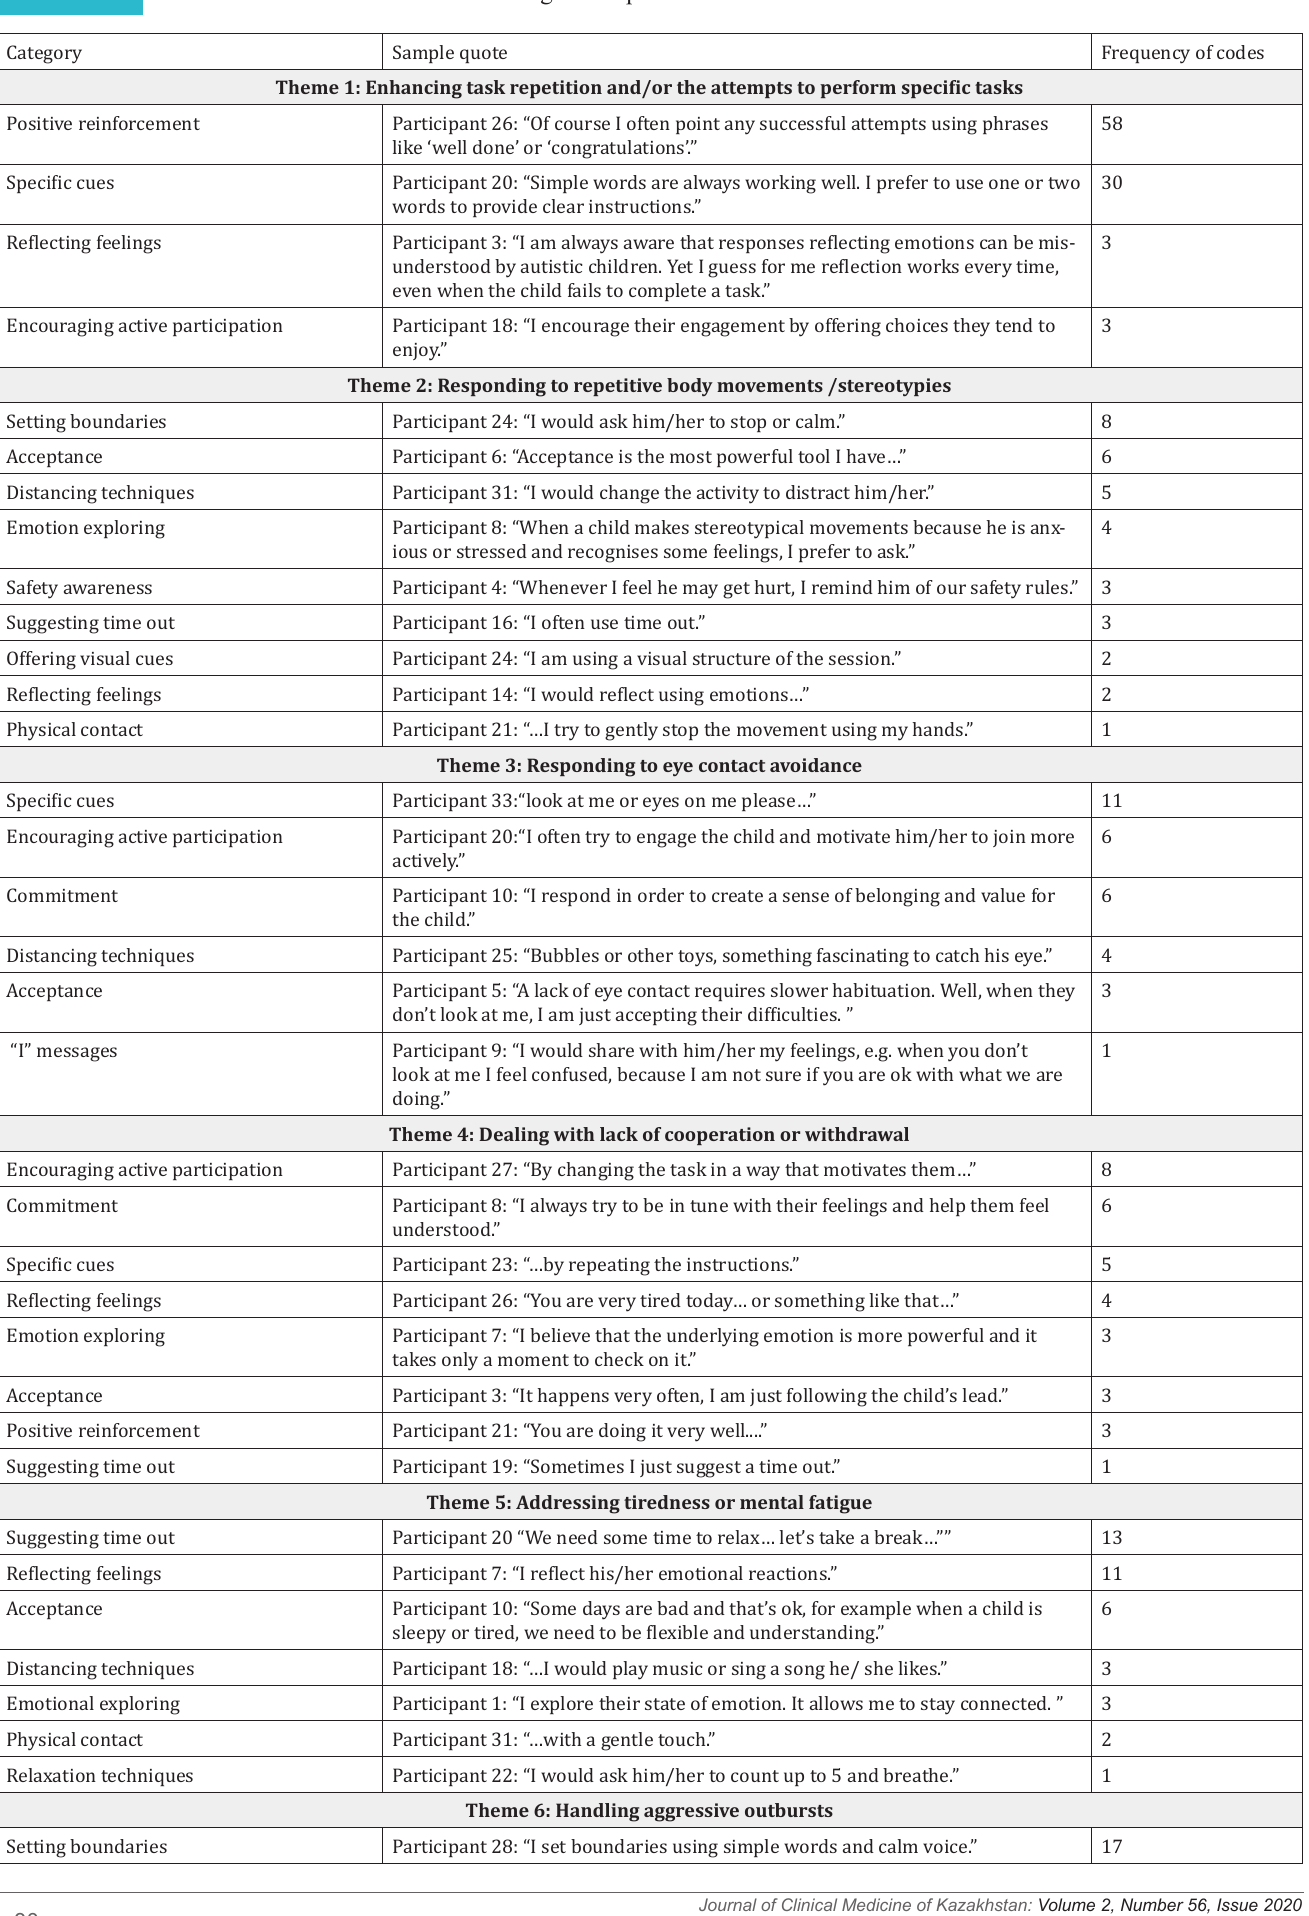
Table 2 Communication and Interaction Strategies in Specific Contexts